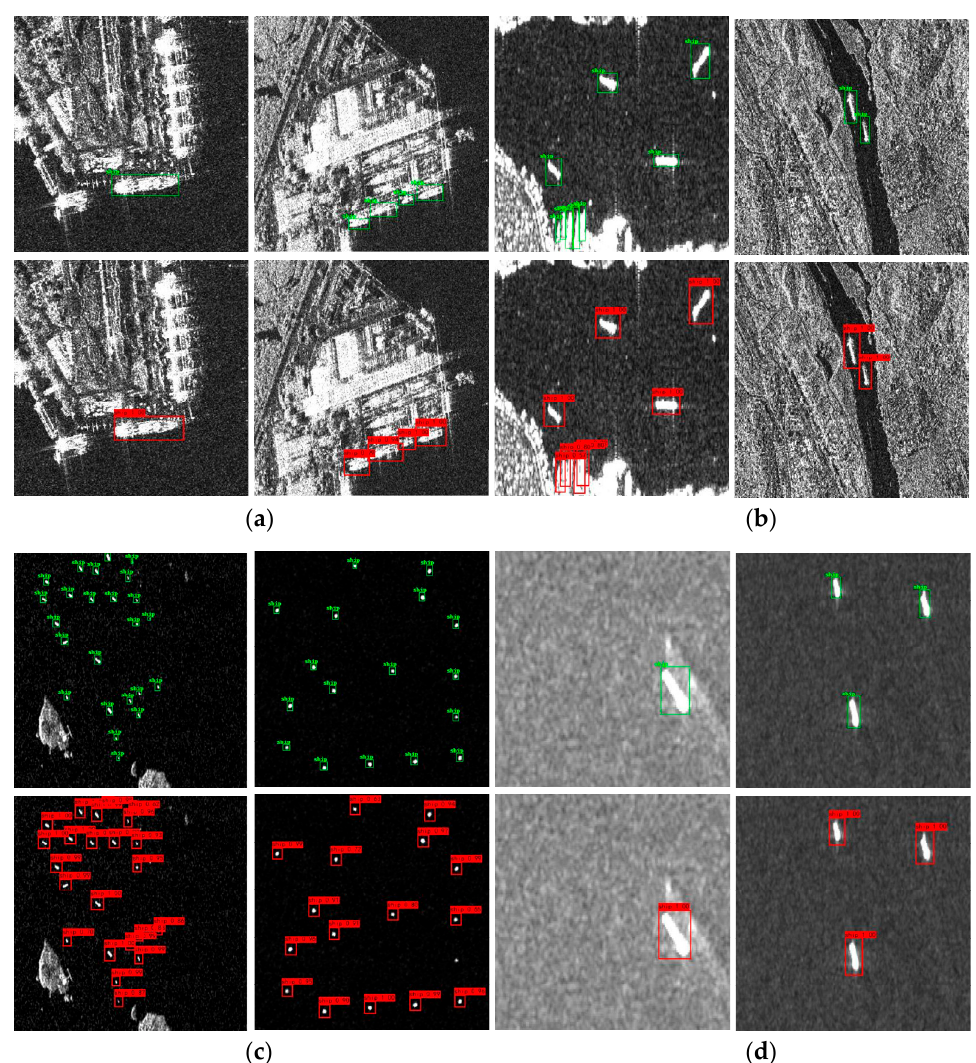
Figure 9. Target detection results of YOLO-V4 in different scenarios (ground truth is marked in green predict result is marked in red): ( a ) shows ship detection docked at an inshore pier, ( b ) shows ship detection in an inshore bay and river, ( c ) shows ship detection of small targets in wide-open water far out at sea, and ( d ) shows ship detection under the influence of low resolution and scattered noise.